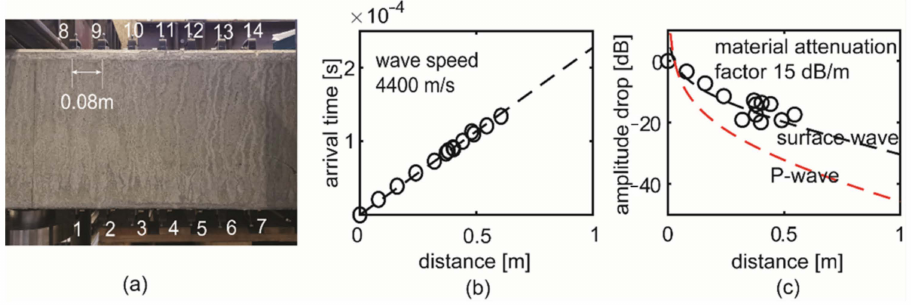
Figure 8. Preliminary test on wave propagation: ( a ) the fourteen sensors on top and bottom sur- faces, ( b ) estimation of wave speed from arrival times, and ( c ) estimation of wave attenuation from amplitude drop.